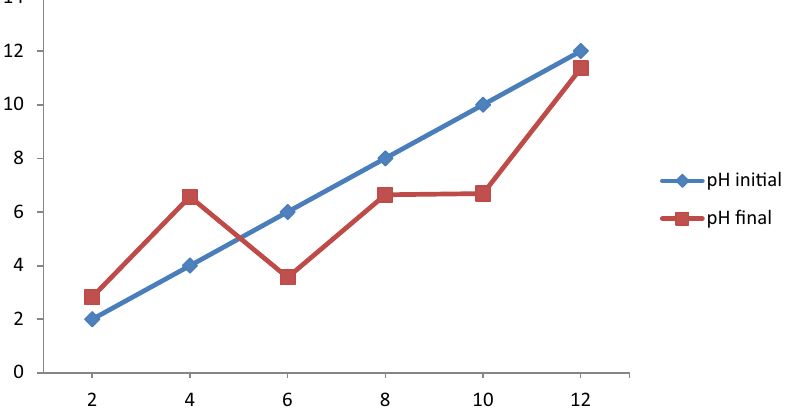
Figure 2. pHpzc of Rumex abyssinicus activated